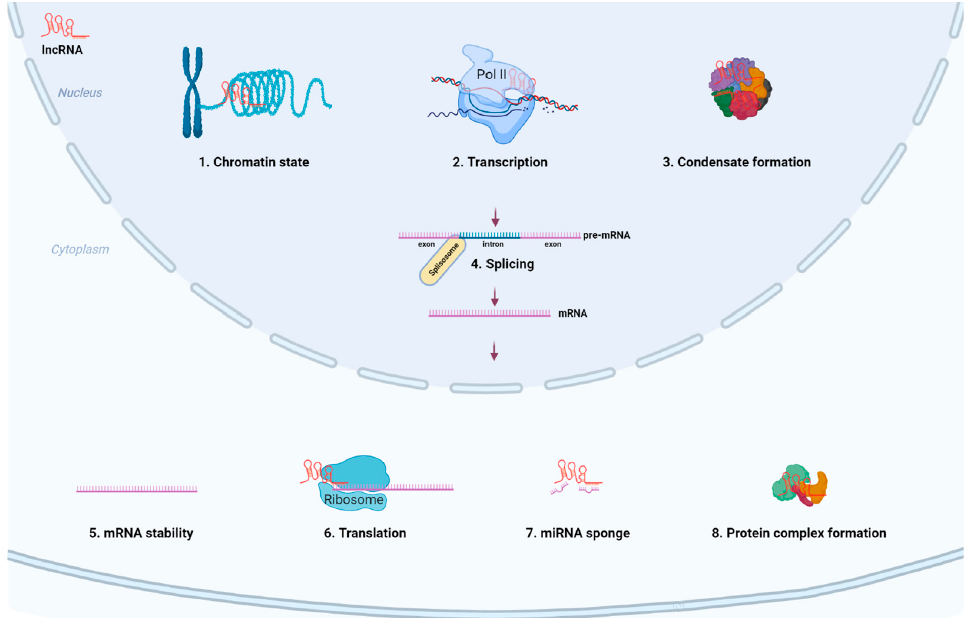
Figure 2. Main biological functions of lncRNAs in cells. In general, lncRNAs with multiple exons are exported to the cytoplasm similar to mRNAs, while intronic lncRNAs are retained in the nucleus. Due to the flexible structure and long size, lncRNAs interact with DNA, RNA, and protein, thereby regulating chromatin state (histone modification, DNA methylation), transcription, pre-mRNA stability as well as splicing and processing, nuclear condensate formation (i.e., paraspeckles, nuclear speckles), mRNA stability, translation, and sponging miRNAs as well as orchestrating protein complex formation. The figure is created with Biorender (Biorender.com (accessed on 28 January 2022)).